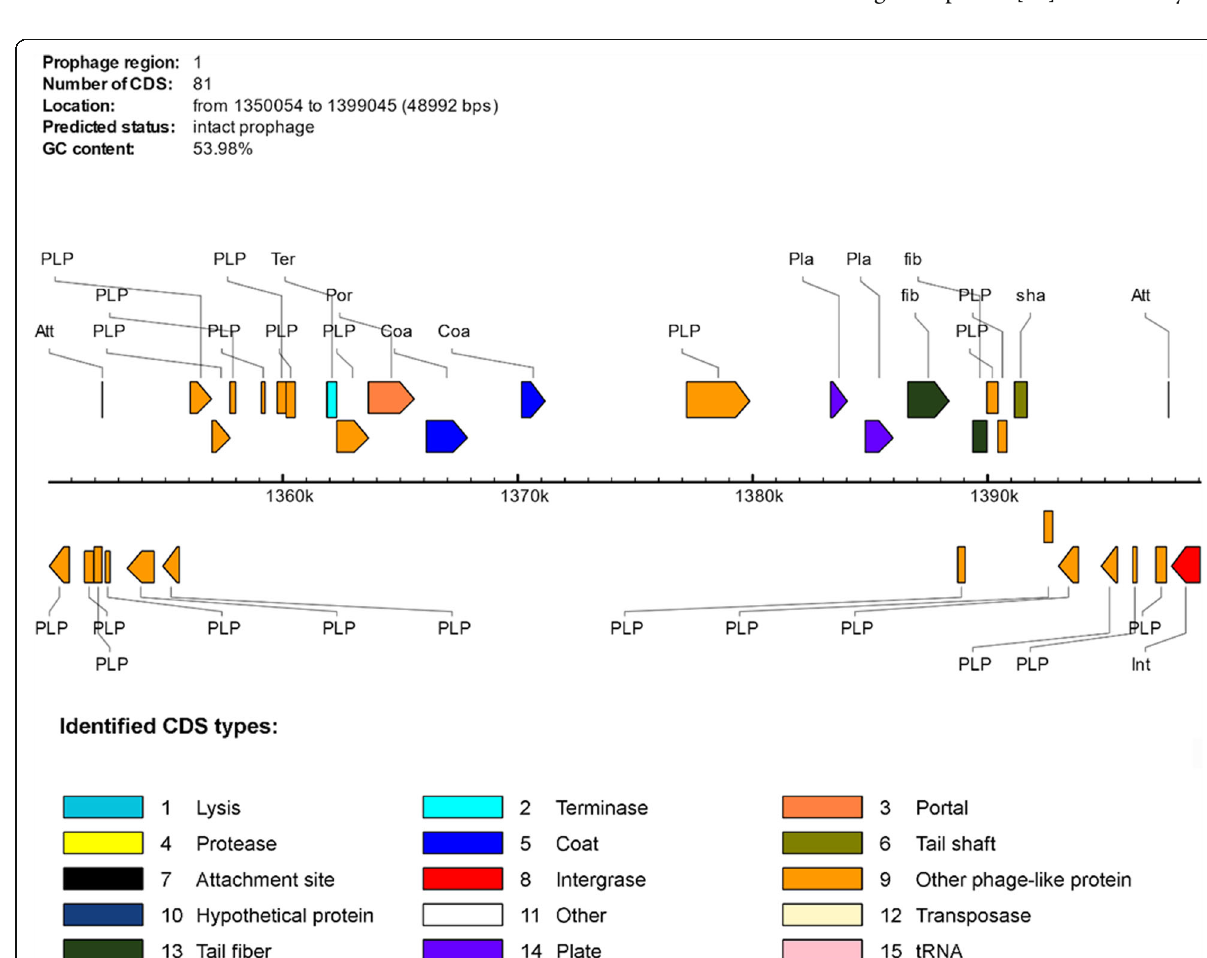
Fig. 4 Graphic showing phage related proteins identified in the intact prophage by PHAST. The diagram above was annotated by and imported from the PHAST-prophage database. Twenty-six hypothetical proteins were removed from the schematic to increase the clarity of the phage related proteins. The proteins above the black line indicating genome position are encoded 5 ′ to 3 ′ while the proteins under it are encoded 3 ′ to 5 ′ . The abbreviations in the diagrams are as follows Att (phage attachment site), Coa (Phage coat protein), fib (Phage Tail Fiber), Int (Phage integrase) Pla (Phage plate protein), PLP (Phage like protein), Por (Portal protein) sha (Phage tail shaft protein) Ter